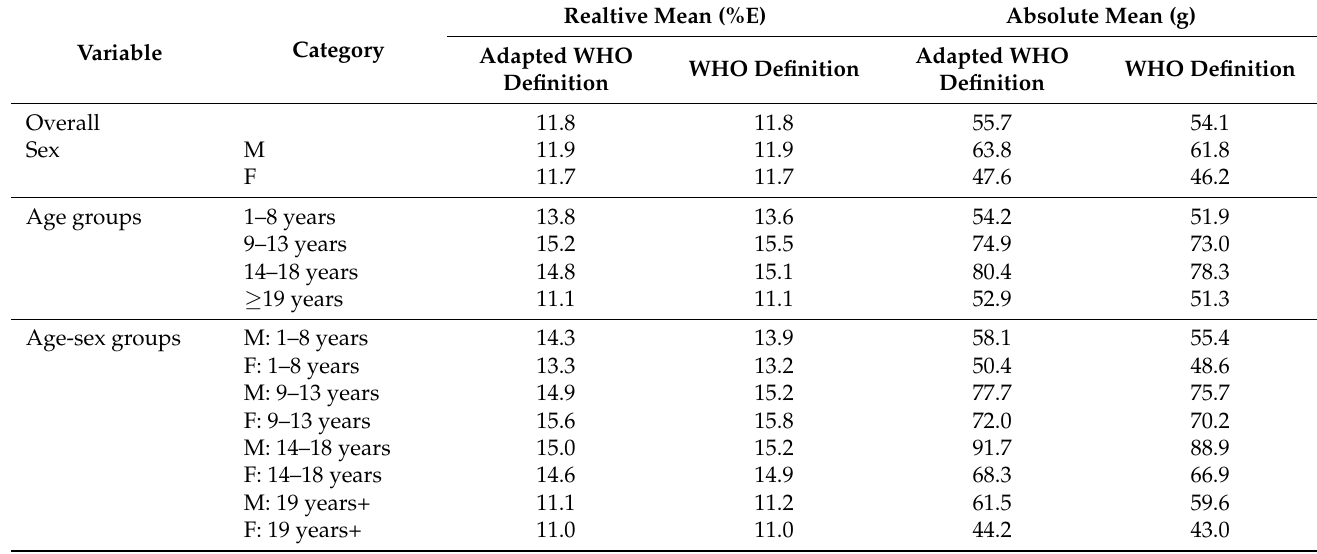
Table A2. Comparison of the Mean Intakes of FS When Applying the WHO Definition vs. Our Adapted WHO Definition.